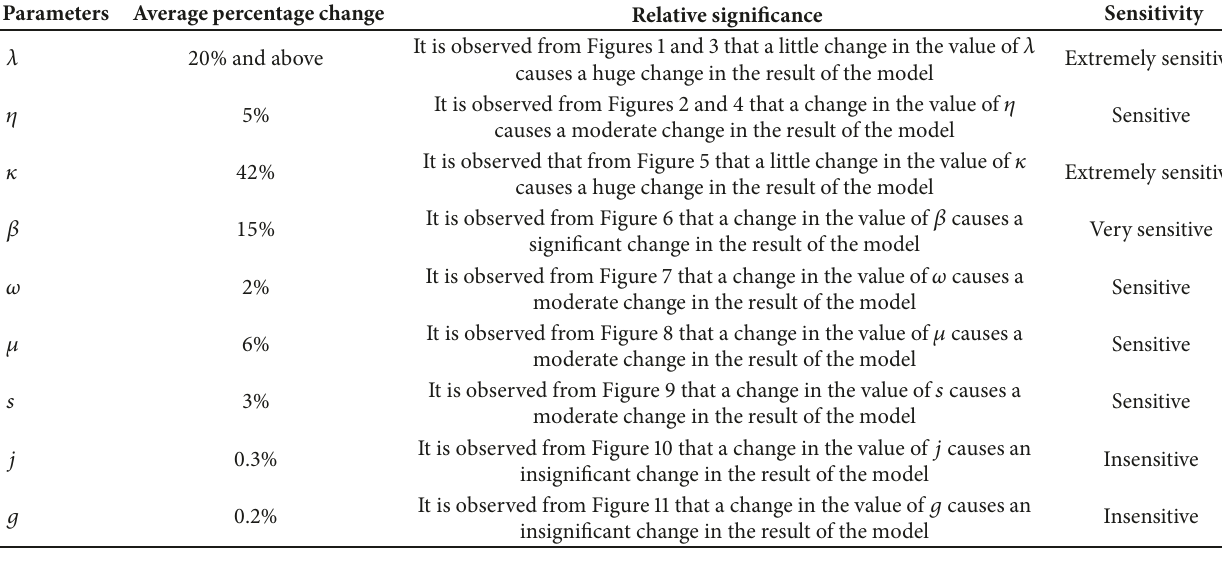
Table 5: Effect of parameter estimations on model.